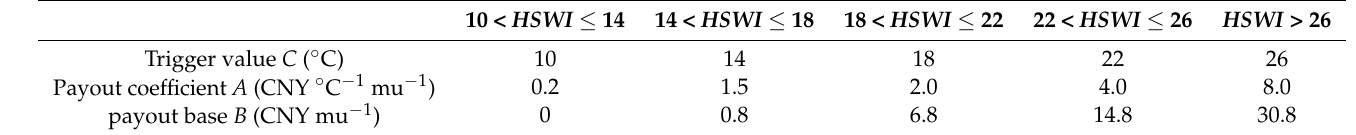
Table 1. Trigger value and payout standard of rice heat stress weather index insurance [36].